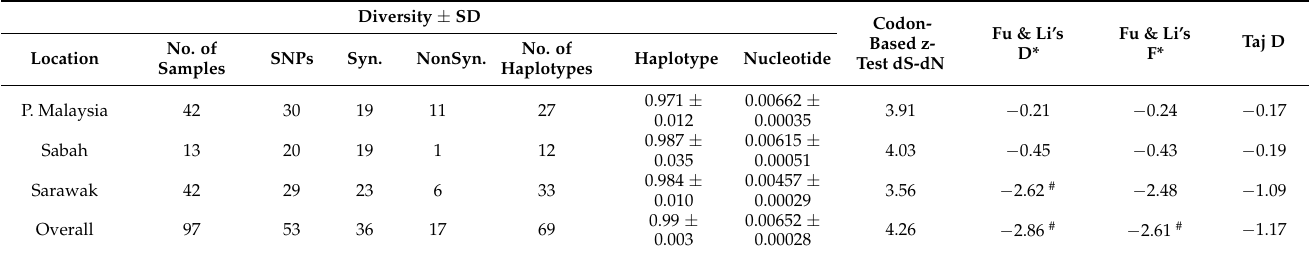
identical to reference strain H (PKNH_1436700) are indicated in the top row Hap 1. The maroon color indicates the SP domain, green color indicates the TSR domain and blue color indicates the TM domain. Total number of haplotypes indicated in right panel. Dots represent identical amino acid, and the numbers in vertical represent the position of the amino acids with respect to the H-strain. Table 1. Estimates of nucleotide diversity, haplotype diversity and neutrality indices.